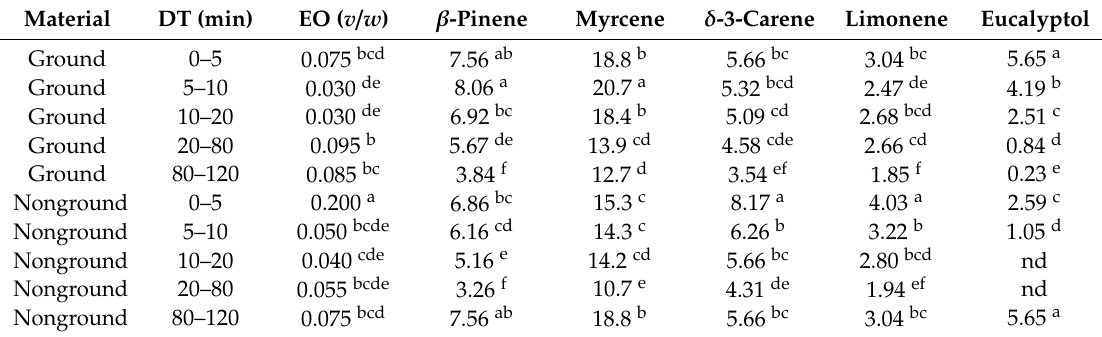
Table 2. Mean Essential oil (EO) content ( v / w fresh material) and concentration (% of total oil) of β -pinene, myrcene, δ -3-carene, limonene, and eucalyptol obtained from the 10 combinations of Material and Distillation time